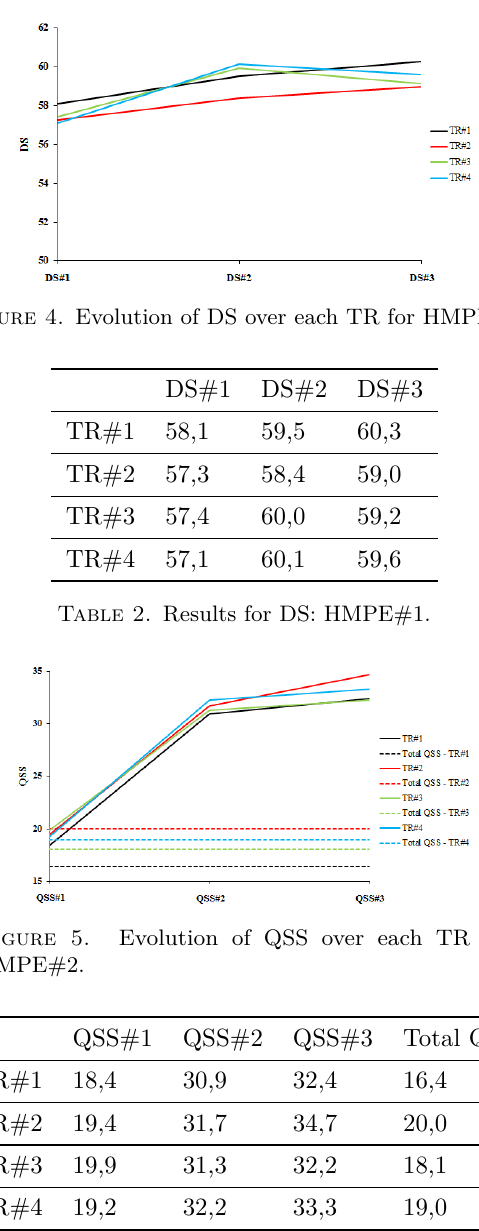
Table 3. Results for QSS: HMPE#2.